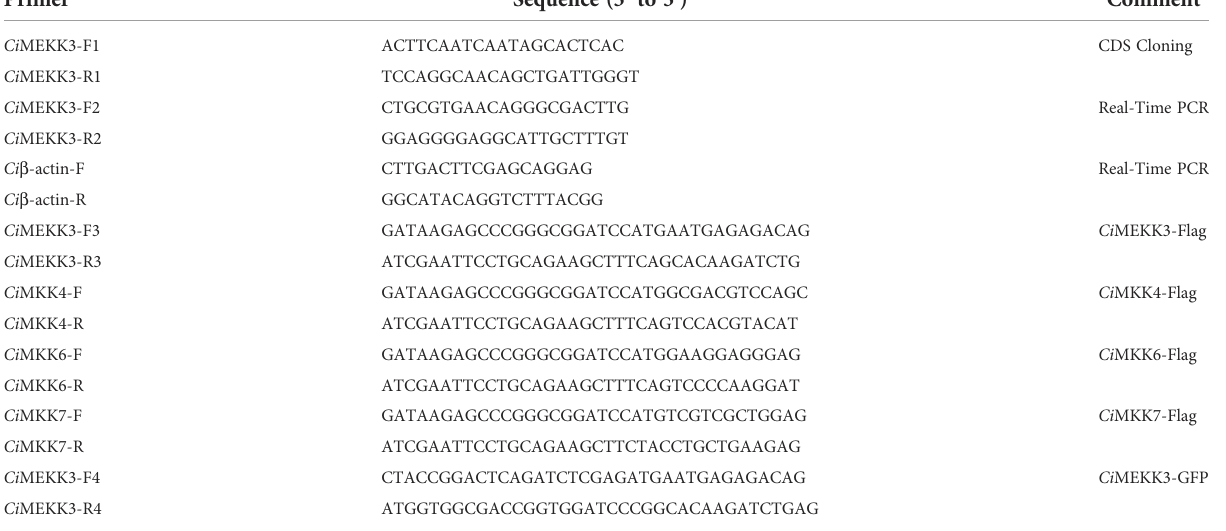
TABLE 1 Sequences of designed primers used in this study. Primer Sequence (5 ’ to 3 ’